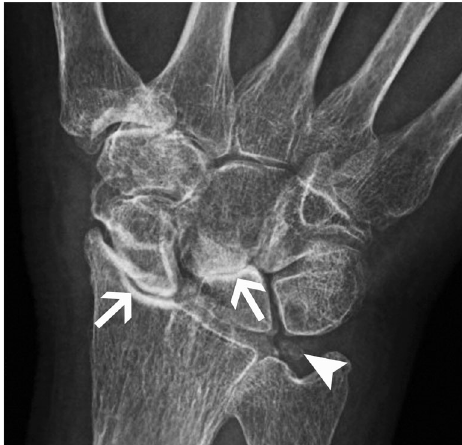
Fig. 10 CPPD arthropathy of the wrist. Posteroanterior radiograph of the wrist shows joint space narrowing and dense subchondral sclerosis at the radioscaphoid and lunocapitate joints (arrows) associated with widening of the scapholunate space, consistent with a SLAC wrist. Note chondrocalcinosis at the ulnocarpal joint space within the triangular fibrocartilage